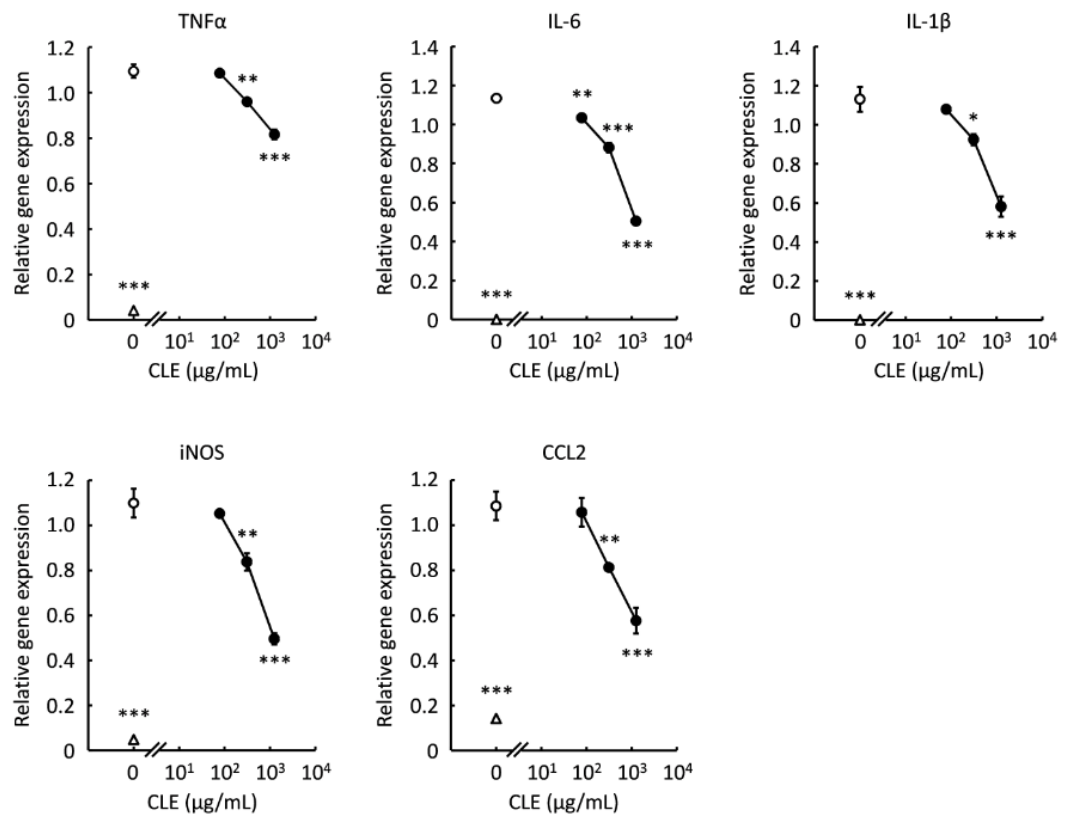
Figure 4. Effect of an aqueous extract from leaves of Citrus unshiu (CLE) on gene expression of proinflammatory proteins in RAW 264.7 cells. RAW 264.7 cells were treated with various concentrations of CLE for 24 h, followed by LPS stimulation for 24 h. Total RNA was then extracted from the cells and used for measuring relative gene expression of TNF α , IL-6, IL-1 β , iNOS, and CCL2 by real-time RT-PCR. An open circle indicates the LPS-stimulated cells treated with water instead of CLE (control). An open triangle indicates the cells not stimulated with LPS. Data are represented as mean ± SEM of three independent experiments. * p < 0.05, ** p < 0.01, or *** p < 0.001 against control by Dunnett’s test.